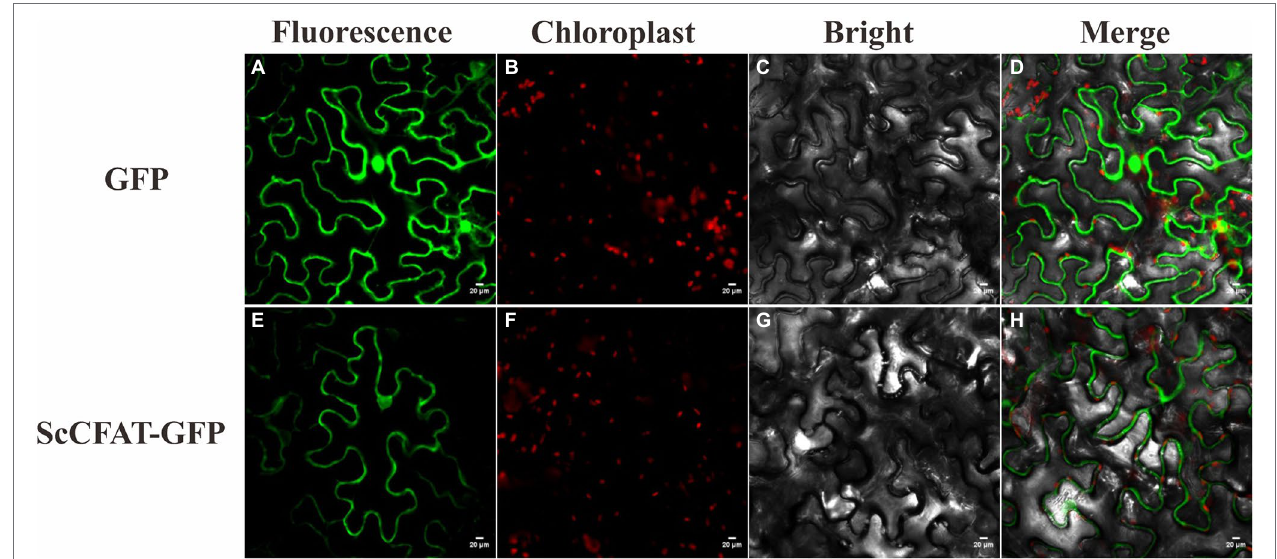
FIGURE 6 | Subcellular localization of ScCFAT. The fusion proteins were observed under a confocal laser scanning microscope. a, e show the green fluorescence channel; b, f show the chloroplast autofluorescence channel; c, g show the bright field channel; and d, h were created from the images shown in the first three panels. Scale bar = 20 μ m.